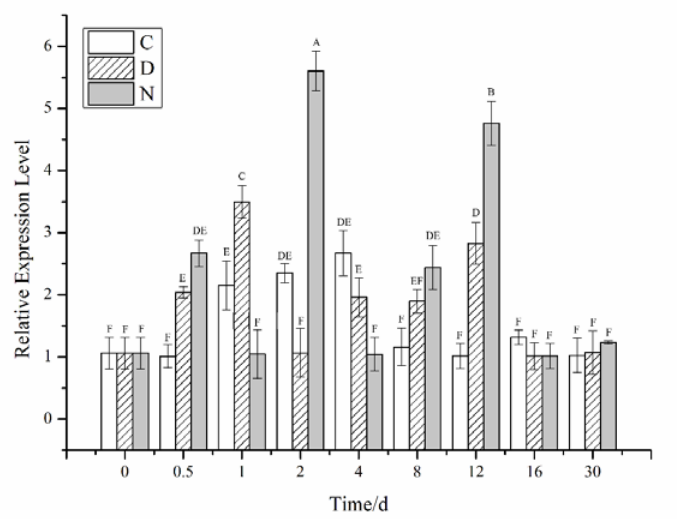
Figure 6. Relative expression of the CiPlant-CRY1 in different photoperiods for different times. C: normal light (12 h light:12 h dark), D: polar day (continuous light), N: polar night (continuous dark). Standard error bars are shown, n = 3. Different capital letters indicate significant differences between different treatments ( p < 0.01).